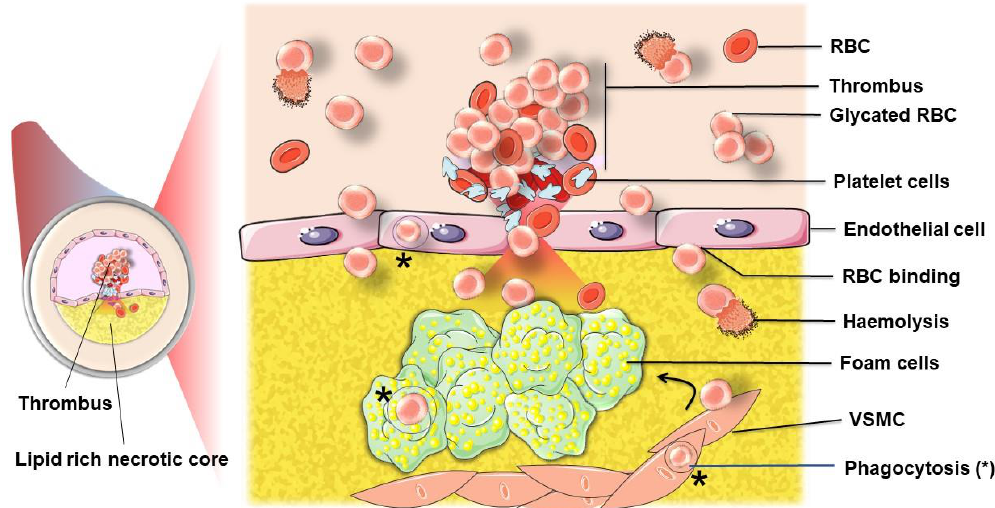
Figure 9. Participation of RBCs to atherothrombosis. Following plaque rupture, RBCs can further infiltrate the plaque where they are either phagocytosed (*) by endothelial cells, macrophages and vascular smooth muscle cells (VSMC), or lysed. Erythrocytes, by their adhesive and aggregation properties, exacerbated when glycated, also contribute, with platelets, to the thrombus formation. When glycated or aged, phosphatidylserine exposing erythrocytes can further interact with activated platelets [182]. This process participates in the occlusive phenomenon.